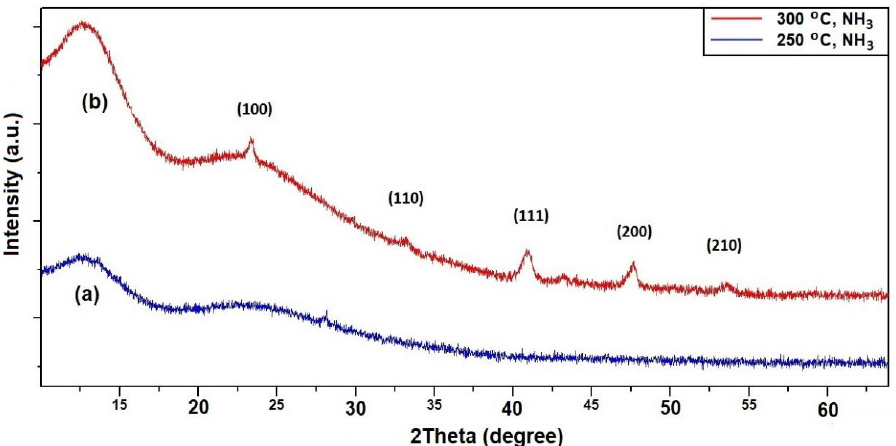
Figure 7. PXD patterns of Cu(OH) 2 /SiO 2 composites heated under flowing NH 3 gas at: ( a ) 250 °C (blue) and ( b ) 300 °C (red). The Miller indices (hkl) for copper(I) nitride, Cu 3 N, are indicated.